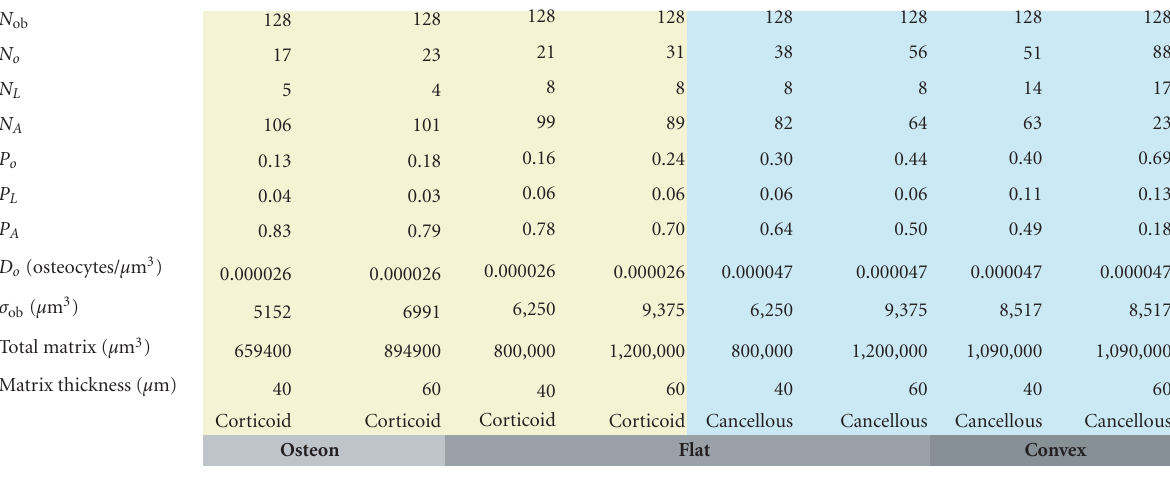
Table 1. The e ff ect of osteocyte density and surface geometry on osteoblast fate and function. This table provides a quantitative assessment of the end result in each geometric configuration illustrated in Figures 8a, 8b, and 8c. Each geometry calculations are based on formation of 40 µ m or 60 µ m thick volume new bone. The table illustrates the fate of the initial set of 128 osteoblasts, identifying the number of osteocytes ( N o ) and lining cells ( N L ) that are required and the probability of an initial osteoblast form an osteocyte ( ρ o ), a lining cell ( ρ l ), or to undergo apoptisis ( ρ A ). Calculations for cortical and trabecular cancellous bone di ff er based on published values for osteocyte density in cortical and trabecular bone. Note that the required probability for osteocyte formation ( ρ o ) increases dramatically in these examples from 0.13 to 0.69 as the surface geometry changes from concave to convex, as the osteocyte density changes from cortical to cancellous bone, and as the thickness of new bone increases.